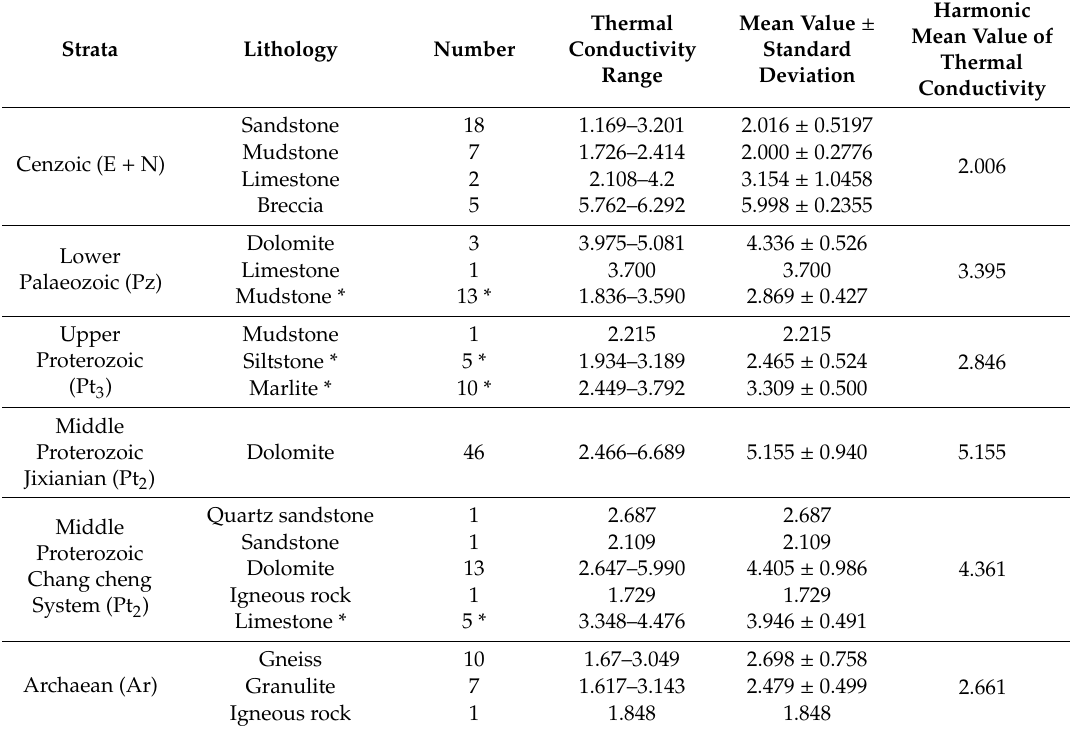
Table 2. Rock thermal conductivity column in the Xiong’an New